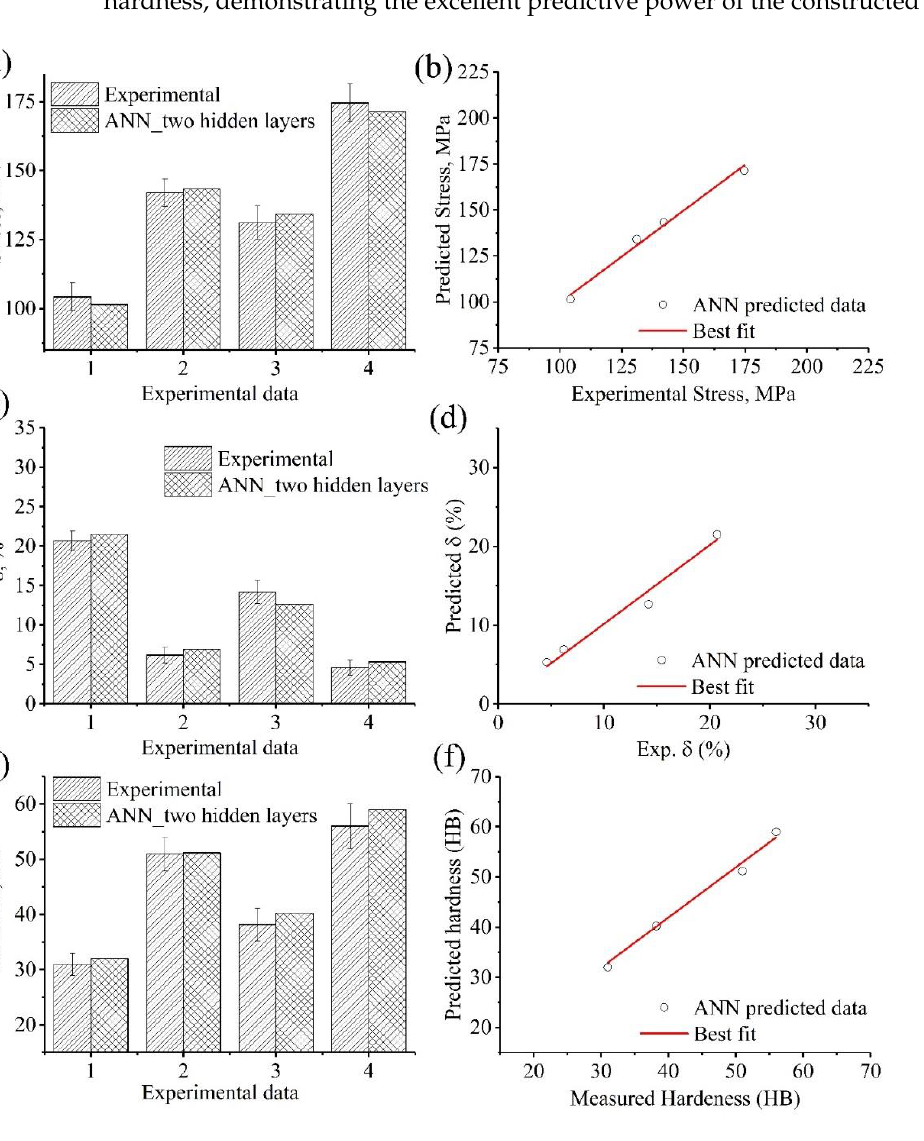
Figure 12. Experimental data compared to the predicted data of the verifications alloys: ( a , b ) stress, ( c , d ) elongation to failure, %, and ( e , f ) hardness, HB.